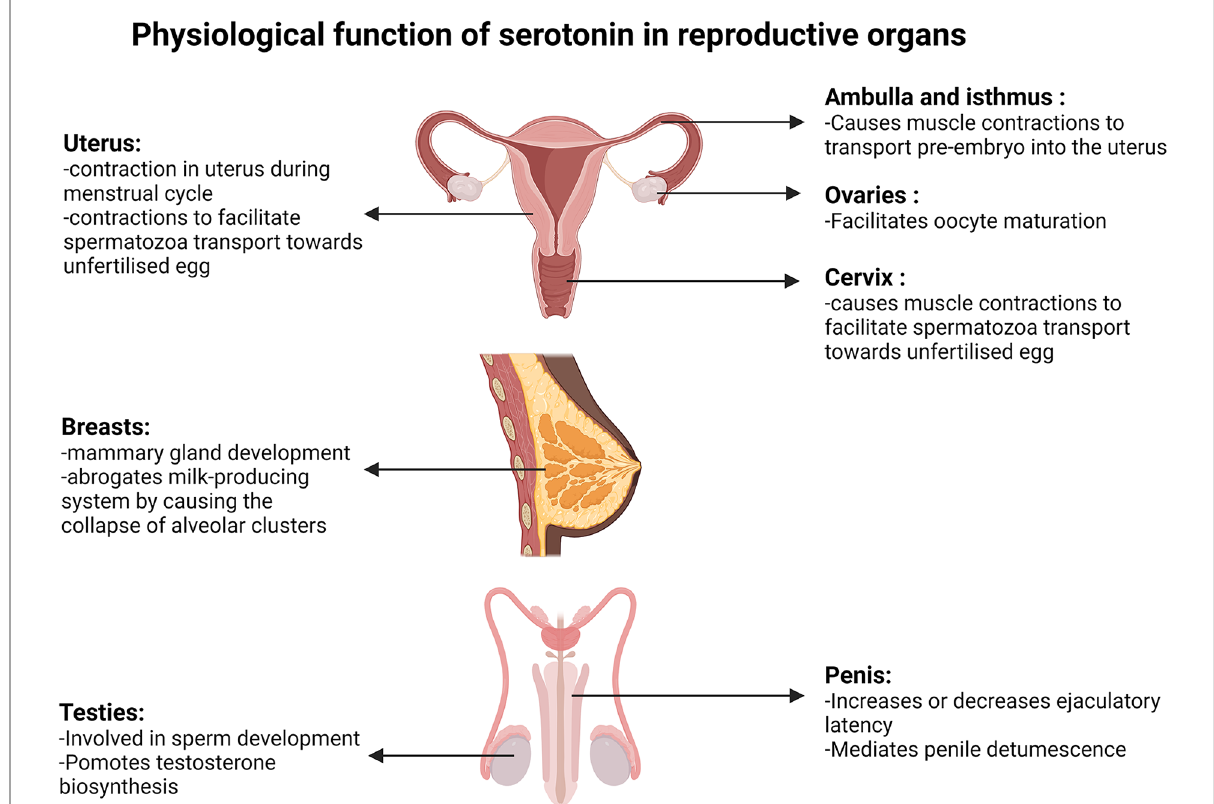
FIGURE 3 Physiological function of serotonin in reproductive organs. Diagrams present the function of serotonin in the uterus, fallopian tube, ovaries, cervix, breasts, testis and penis. Created with